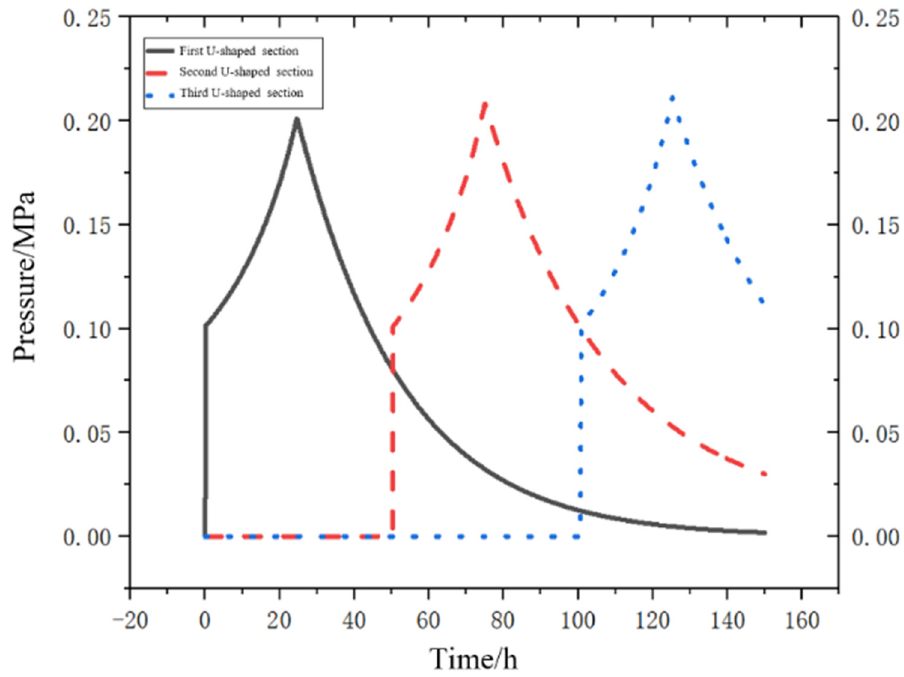
Figure 14. Variation in the pressure of a gas section in the multi-pipe simulation example.